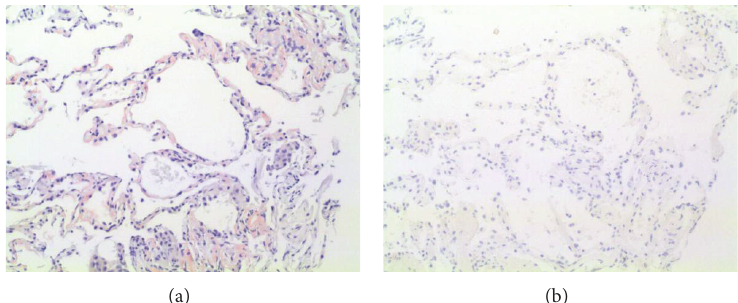
Figure 2: (a) Pulmonary parenchyma with amyloid deposition showed by Congo red staining. 10x. (b) The same image but negative for amyloid immunochemistry.